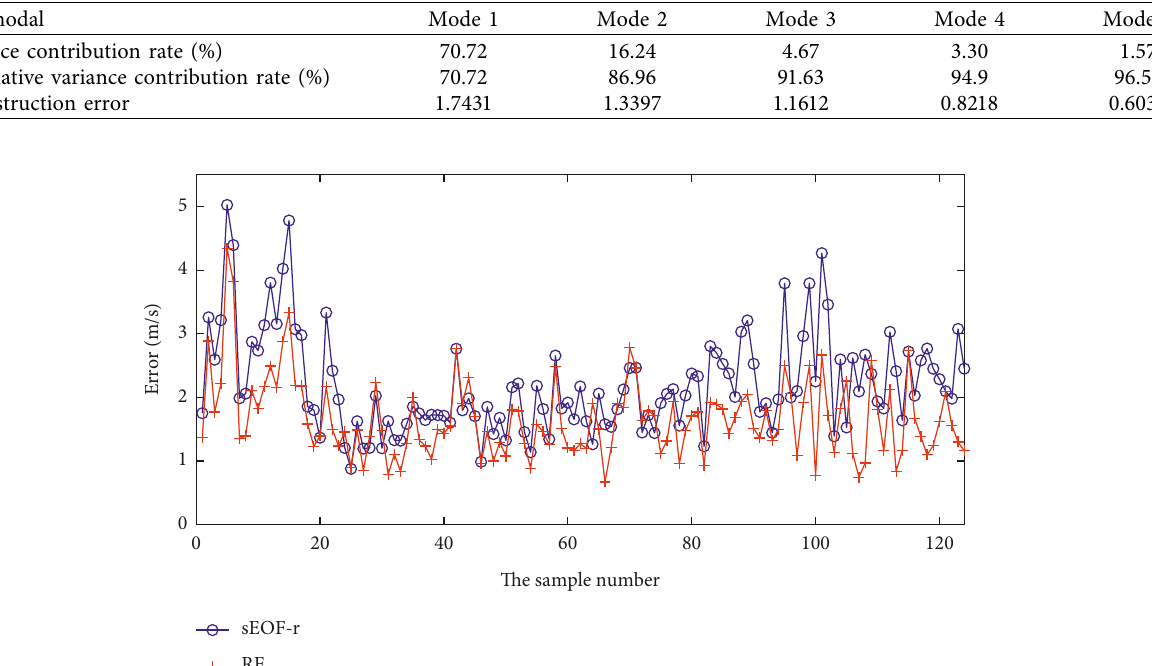
Table 1: Variance contribution rate and error of the first five-order EOF reconstruction.